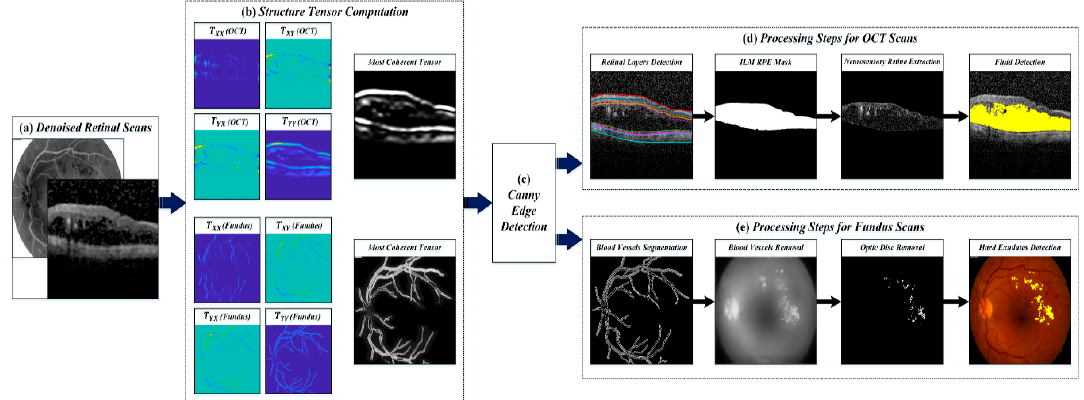
Figure 6. Extraction of clinically significant ME pathological symptoms. ( a ) Denoised retinal scans; ( b ) structure tensors computation stage; ( c ) detection of edges using the canny edge detection method; ( d ) processing steps for OCT scans and ( e ) processing steps for fundus scans.